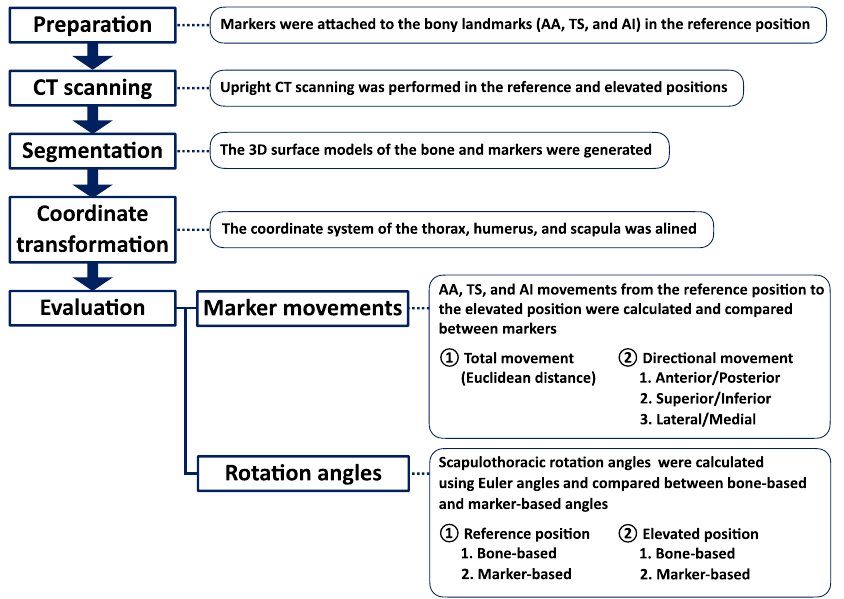
Figure 1. Flowchart of this study. CT, computed tomography; AA, acromial angle (angulus acromi- alis); TS, root of the scapular spine (trigonum spinae scapulae); AI, inferior angle (angulus inferior).